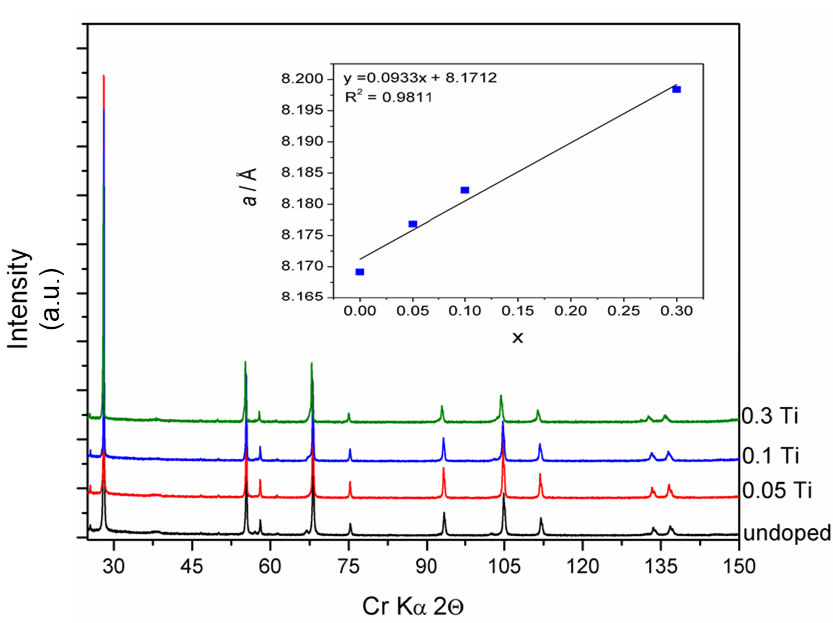
Figure 4. XRD patterns of synthesized LMNTO materials. Inset shows changes in lattice parameters as a function of substitution level.